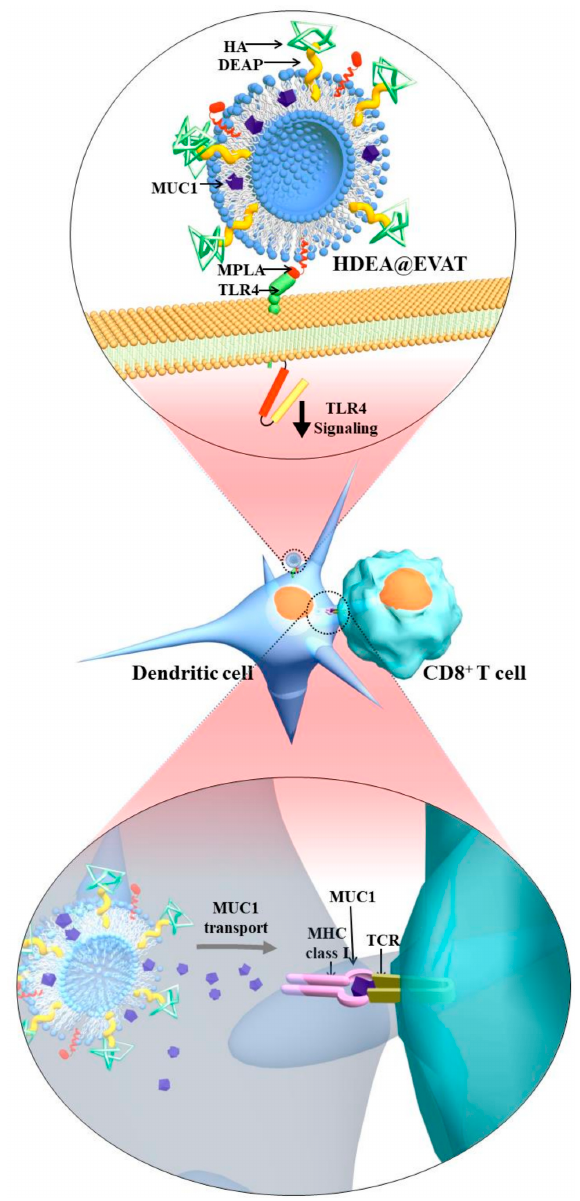
Figure 1. Schematic illustration of dendritic cell (DC) ‐ targeted pH ‐ responsive HDEA@EVAT and the intracellular process for CD8 + T ‐ cell activation.